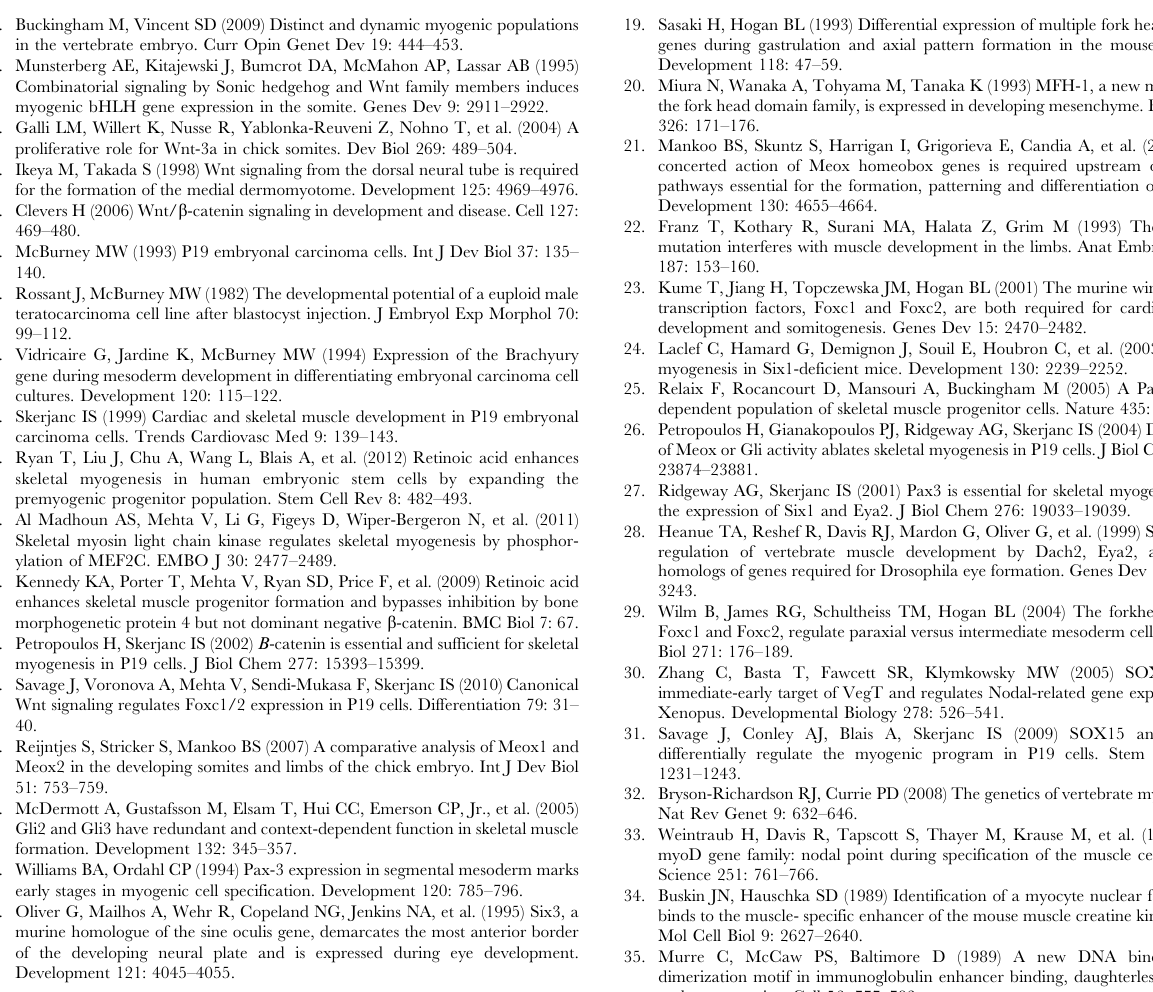
Figure S1 RA enhanced the expression of MRFs